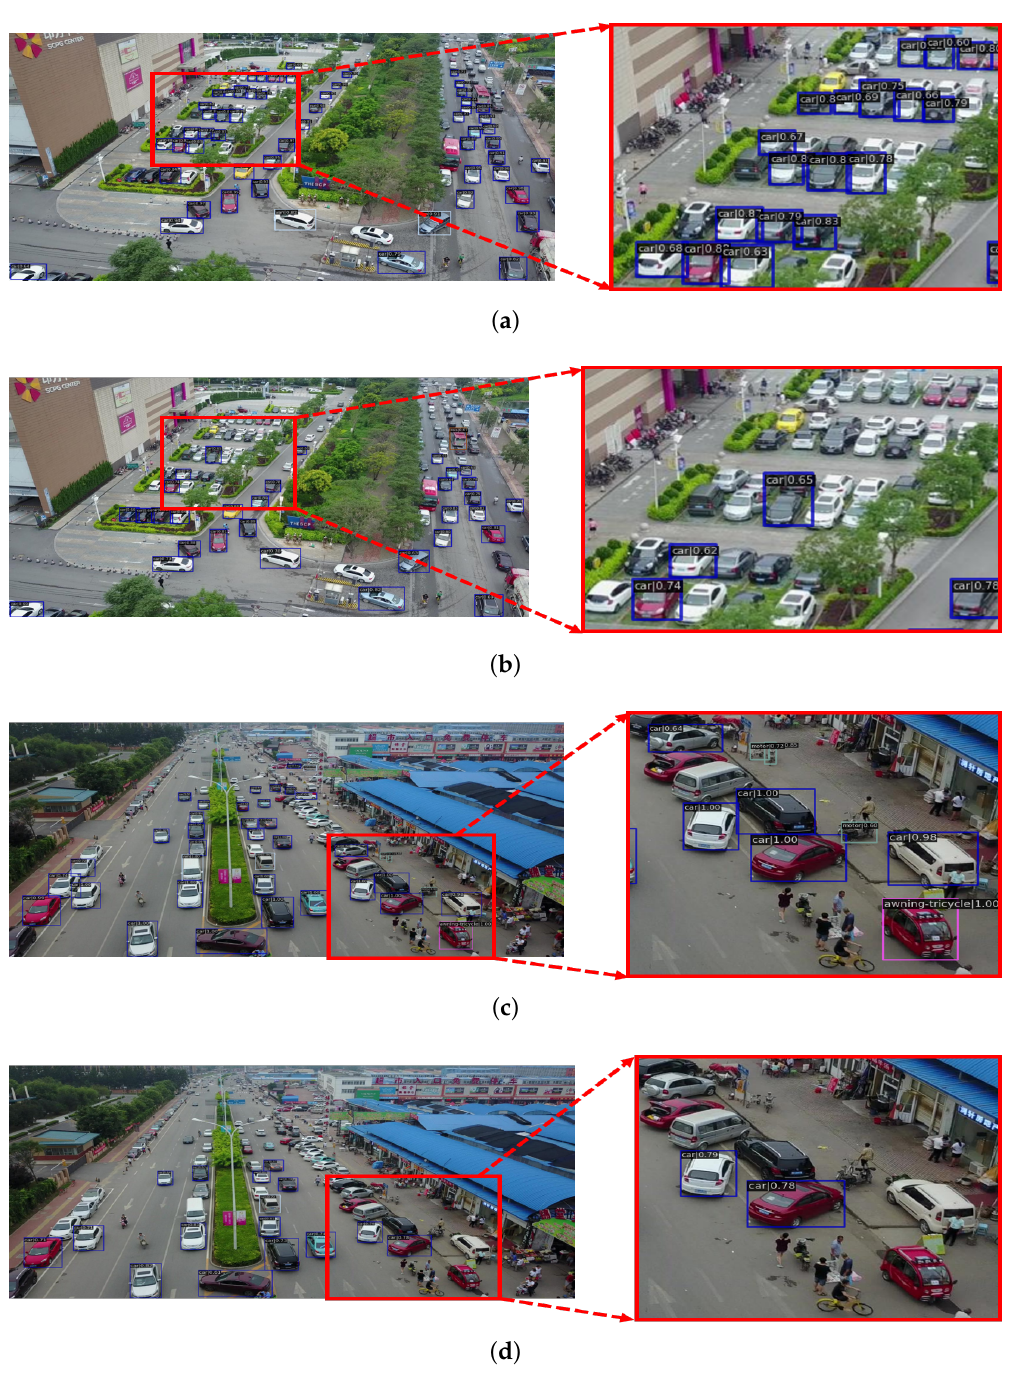
Figure 10. Selected comparison graphs of the detection results on the Visdrone dataset regarding Swin Transformer and FEA-Swin. The test maps for ( a , c ) used FEA-Swin. The test maps for ( b , d ) used Swin Transformer. On the left side of each column is the original detected picture, while on the right side is a zoom-in on the specific details on the left